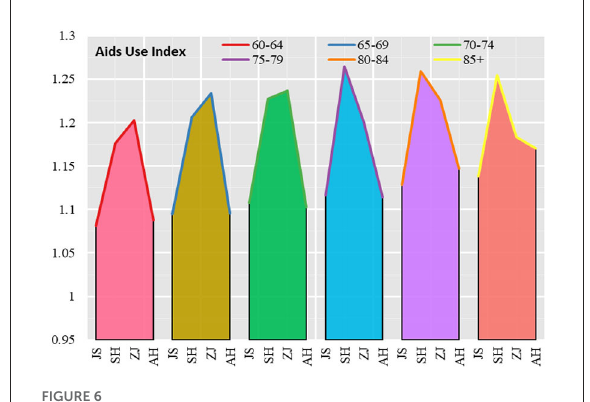
FIGURE6 Aids Use index for elderly people in Jiangsu, Shanghai, Zhejiang and Anhui.